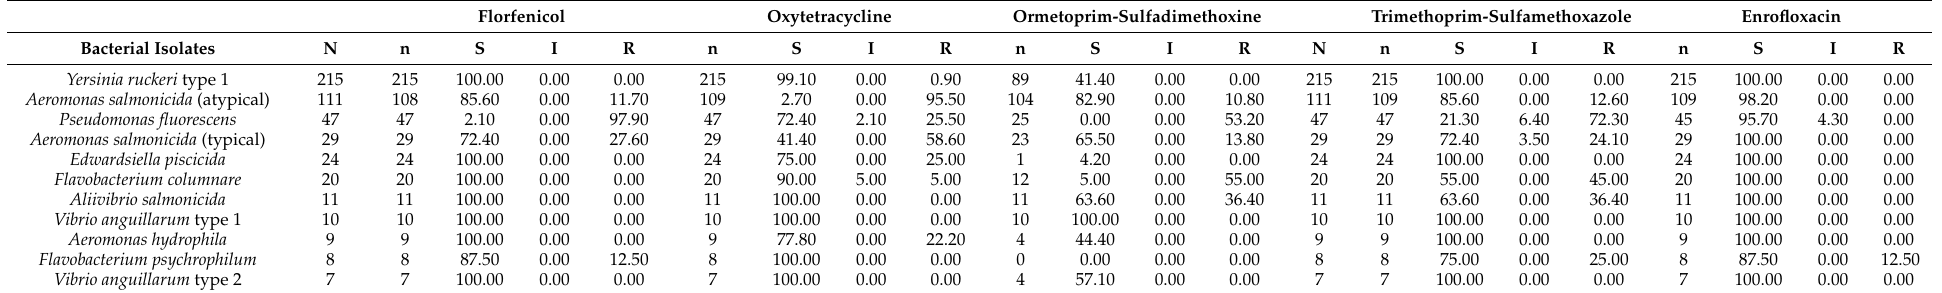
Table 3. Antimicrobial susceptibility profiles (% S, I, and R) for tested antimicrobials in bacterial isolates from samples of salmonids